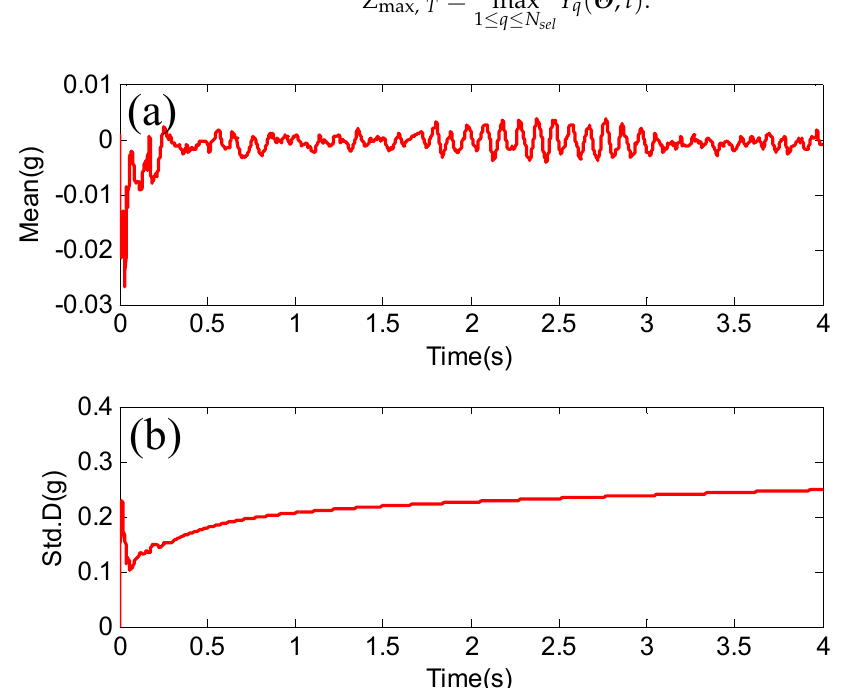
Figure 4. Ensemble average characteristics of the vibration acceleration of the superstructure of the tunnel: ( a ) mean; ( b ) standard deviation.